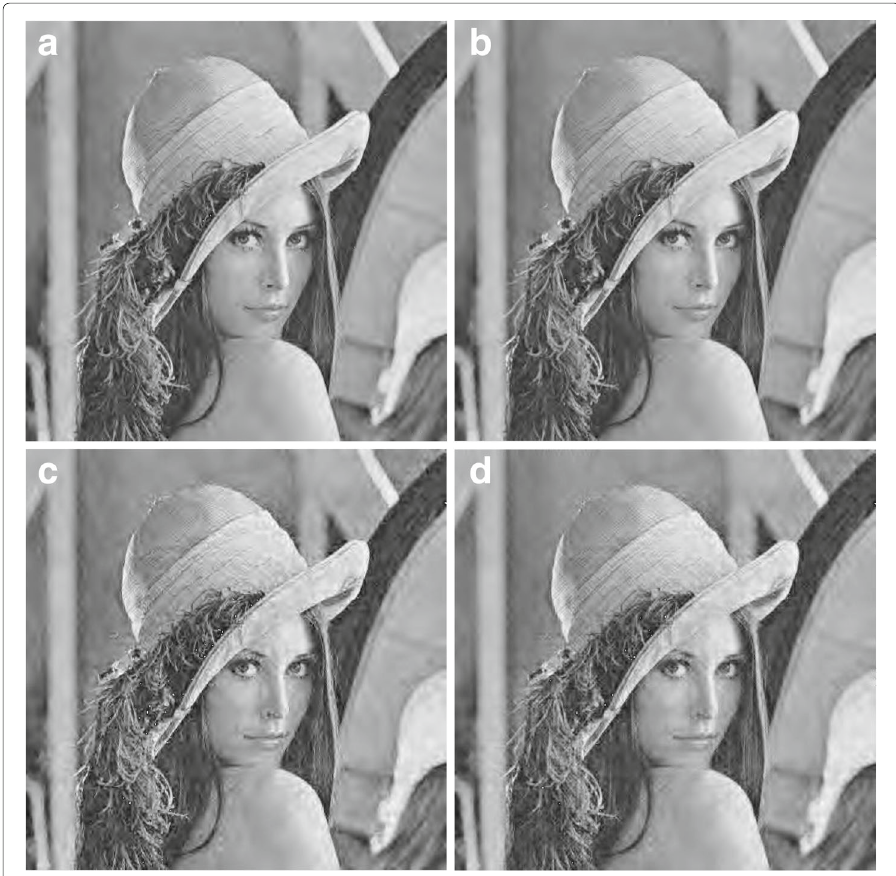
Fig. 6 Comparison of reconstructed images of “Lena” by the proposed predictive side decoding and the conventional side decoding : a the conventional 2-description side decoding (PSNR = 28.31 dB) versus b the proposed predictive 2-description side decoding (PSNR = 29.69 dB) at the same total bit rate of 0.537 bpp; c the conventional 1-description side decoding (PSNR = 26.43 dB) versus d the proposed predictive 1-description side decoding (PSNR = 27.68 dB) at the same total bit rate of 1.012